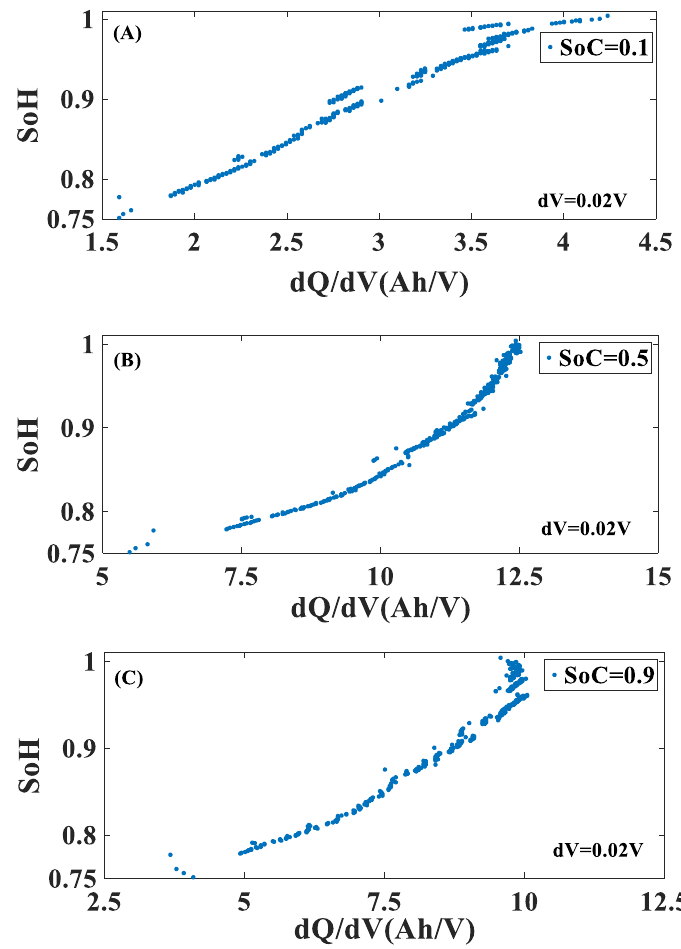
Figure 2. SoH of the tested battery plotted as a function of dQ / dV in full cycle for ( A ) SoC = 0.1, ( B ) SoC = 0.5, and ( C ) SoC = 0.9.